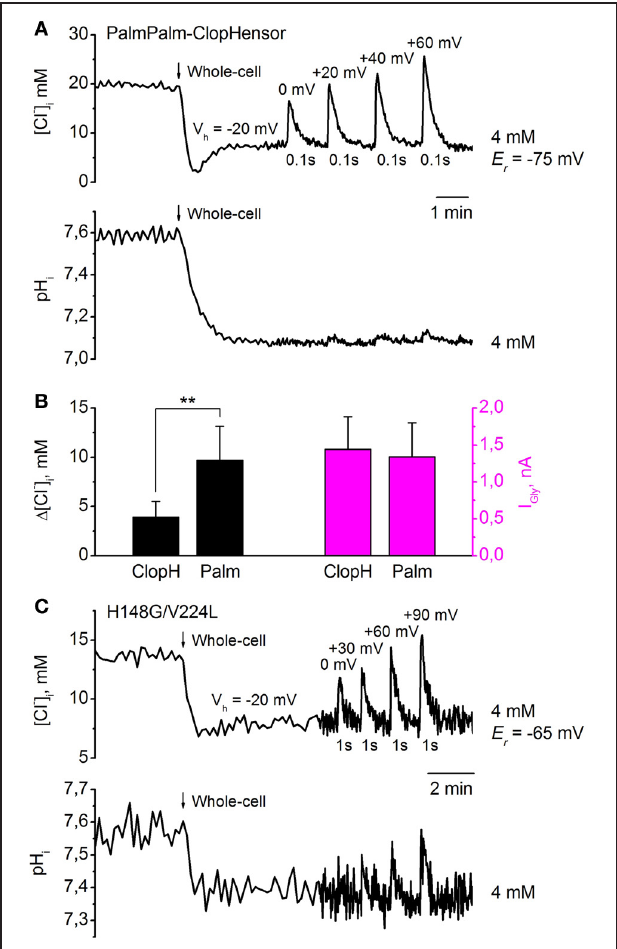
FIGURE 9 | Monitoring of transients in [Cl − ] i and pH i in response to GlyR activation, using PalmPalm-ClopHensor and the H148G/V224L mutant. (A) Changes in [Cl − ] i ( top trace ) and pH i ( bottom trace ) monitored simultaneously by PalmPalm-ClopHensor in a CHO cell co-expressing GlyR and recorded with [Cl − ] p = 4mM. Transients in [Cl − ] i and pH i upon whole-cell penetration and GlyR activation by pressure application of 200 μ M glycine to the cell at different V h and 100ms duration of agonist application are illustrated. The reversal potential for glycine-induced currents ( E r ) is indicated. Note the very small pH i changes at short (100ms) glycine application ( bottom trace ). (B) Averaged glycine-induced current (I Gly ) amplitudes ( magenta columns, right ) and corresponding [Cl − ] i changes ( black columns, left ) in response to 1-s glycine applications. Whole-cell recordings from CHO cells with pipettes containing [Cl − ] p = 4mM. Cells expressed either ClopHensor ( ClopH ) or PalmPalm-ClopHensor (Palm). Note that for very similar I Gly , transients of [Cl − ] i are about 2.5-fold higher when monitored by PalmPalm-ClopHensor than by ClopHensor. Data from seven cells for each sensor are illustrated. ∗∗ P < 0 . 01 (ANOVA). (C) Changes in [Cl − ] i ( top trace ) and pH i ( bottom trace ) monitored by the H148G/V224L mutant of ClopHensor in a CHO cell co-expressing GlyR and recorded with a [Cl − ] p of 4mM. Transients in [Cl − ] i upon whole-cell penetration and GlyR activation by pressure application of 200 μ M glycine to the cell at different V h and 1-s duration of agonist application are illustrated. Note the evident pH i changes of about 0.1 units only under conditions of substantial difference between V h and E r and relatively long (1-s) glycine application. Different baseline noise in the two traces resulted from changes in acquisition frequency from 0.2 to